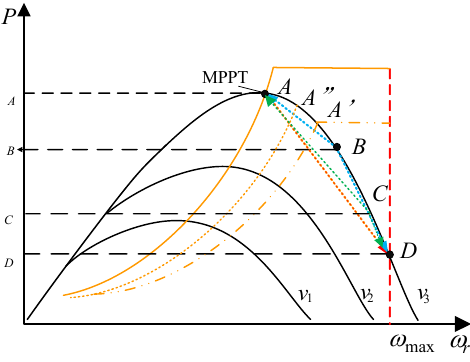
Figure 2. DFIG active power vs. rotational speed.